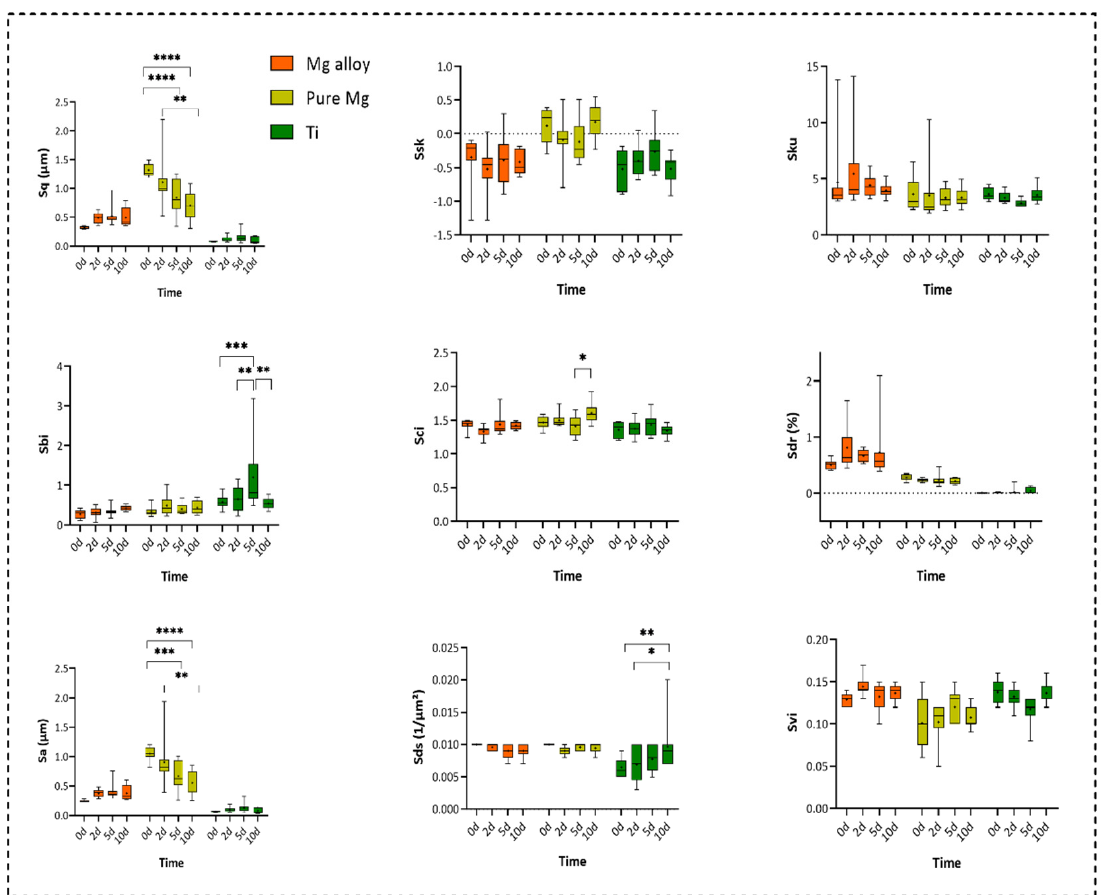
Figure 4. The measurement of surface roughness parameters from Days 0, 2, 5, and 10 including Sq = root-mean-squared height, Ssk = skewness, Sku = kurtosis, Sa = arithmetic mean height, Sbi = surface bearing index, Sci = core fluid retention index, Svi = valley fluid retention index, Sdr = developed interfacial area ratio, and Sds = the summit density (two-way ANOVA post hoc Tukey’s method with statistically significant difference of **** p < 0.0001 *** p < 0.001, ** p < 0.01, * p < 0.05 ).